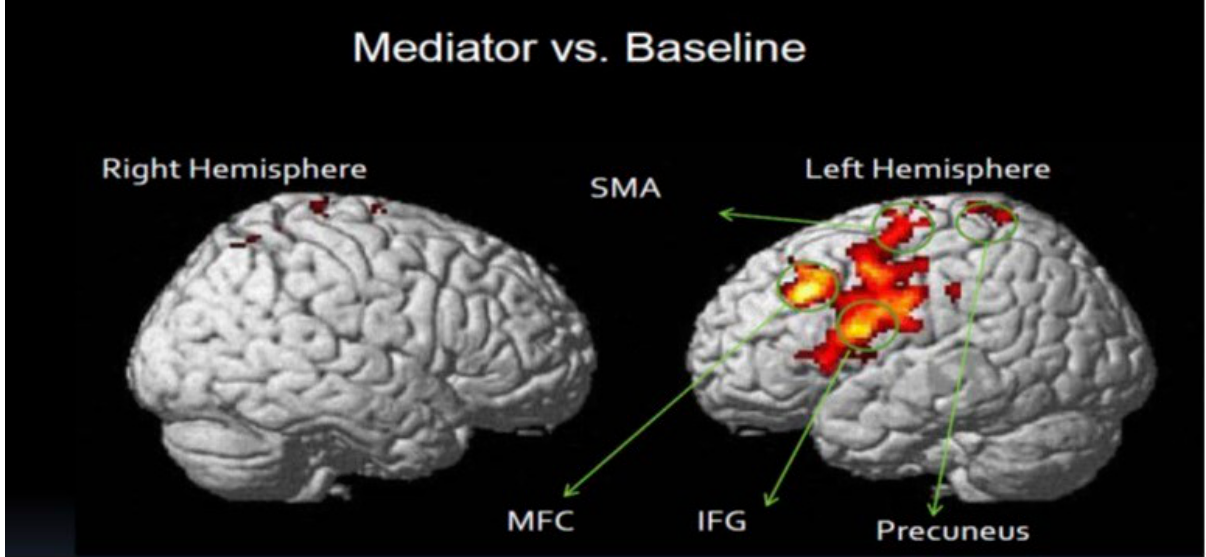
Figure 8. Effect of SOHAM Meditation on the brain. Middle frontal cortex (MFC): This implies regulation of attention, which in the case of meditation is directed at the subjects own mental and bodily state.Left Inferior frontal gyrus (IFG): involved in the cognitive aspects of emotional processing , such as paying attention to emotion or the identification of emotion.Precuneus: involved in the execution or prepara- tion of spatially guided behaviors. Reprinted from Ref. 45, Copyright 2013, with permission from